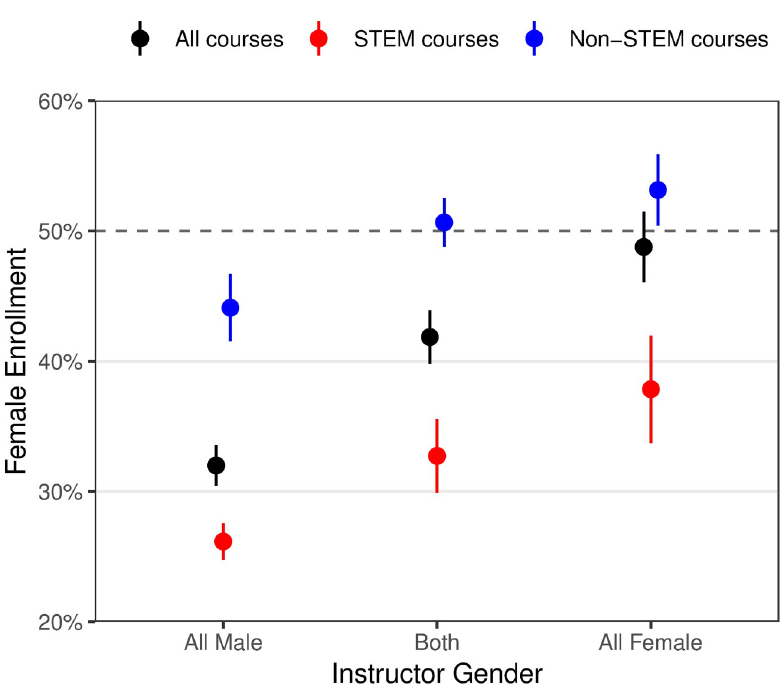
Fig 3. Female enrollment by instructor gender and course discipline. Showing the average enrollment rate in STEM courses (red), non-STEM courses (blue), and all combined (black); error bars are 1 SEM.